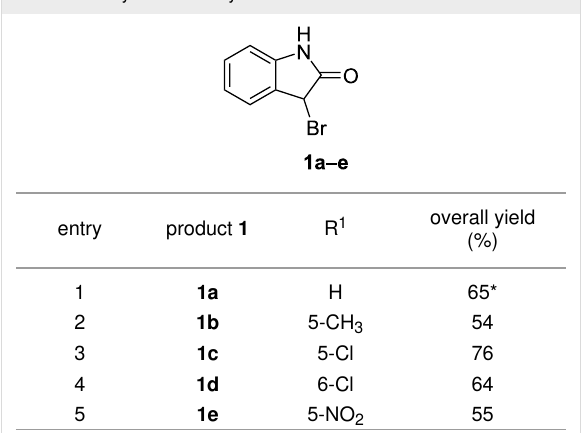
Table 6: The yields of the synthesized 3-bromooxindoles 1a–e .